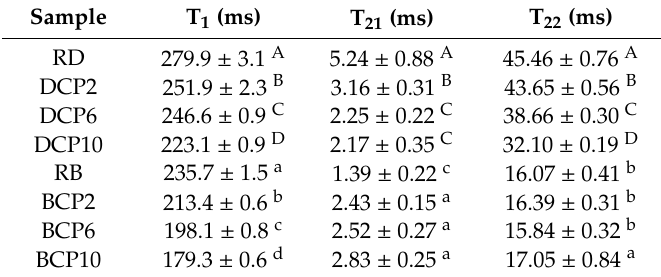
Table 2. Results of 1 H NMR study for dough and bread.